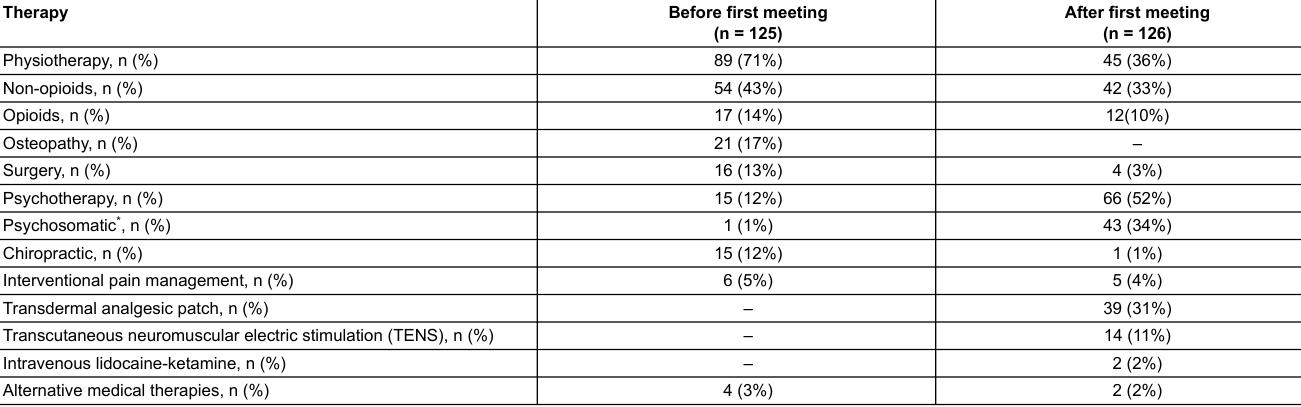
After first meeting (n = 125) (n = 126)